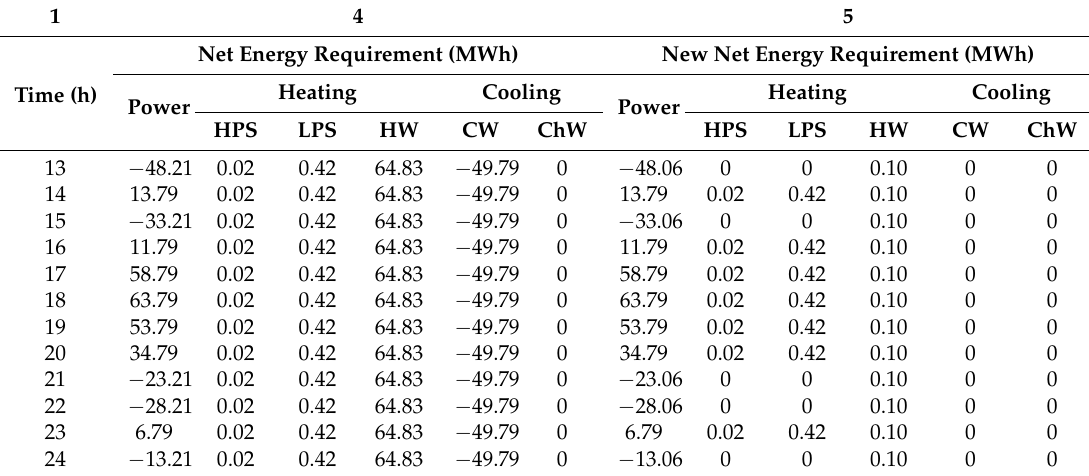
Table A12. TriGenSCA after iteration from 13 to 24 h.